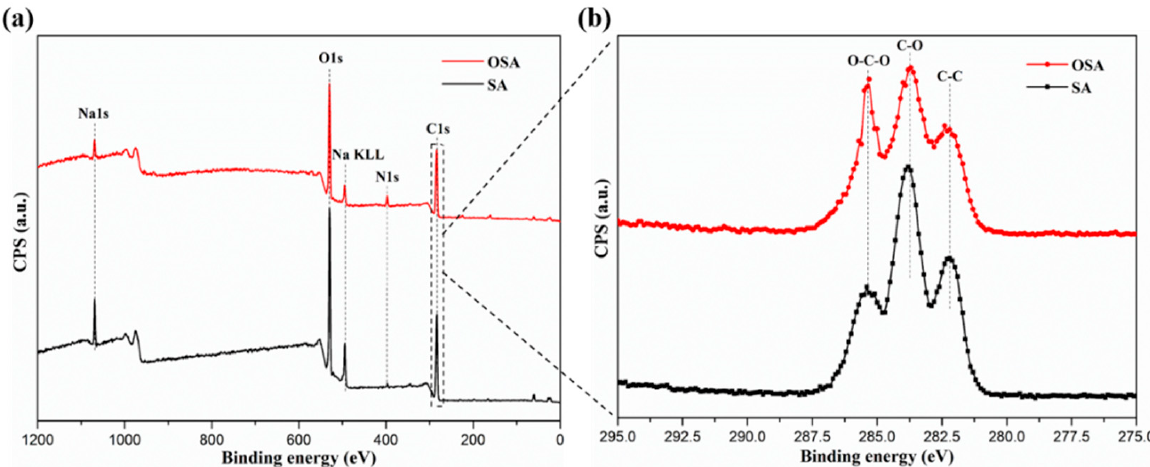
Figure 4. ( a ) FT-IR spectra and ( b ) 1 H NMR spectra of SA and OSA. As a complementary technique, XPS was performed to further verify the surface composition of resultant OSA. As shown in Figure 5a, XPS spectra of SA and OSA confirmed the presence of the anticipated peaks for Na (1069.02 eV), O (530.23 eV), N (397.54 eV), and C (284.68 eV), with an O/Na ratio close to the theoretical value of 6 [43], indicating that partial oxidation of alginate by NaIO 4 preserved the main structure and functional groups of alginate. In addition, the peak assignment of XPS C1s narrow scans of SA and OSA that could elucidate the bonding atmosphere has been marked in the spectra in Figure 5b according to the previous report [44]. It can be observed that the C1s narrow scan revealed three peaks at 285.46 eV (O–C–O), 283.87 eV (C–O), and 282.20 eV (C–C), respectively. It is found that the peak ratio of the O–C–O species to the C–O species in the C1s narrow scan of OSA was significantly higher than that of SA, due to the partial oxidation of alginate by NaIO4, which was consistent with previous results reported by Jejurikar et al. [24]. Thus, these results further verified the successful partial oxidation of alginate by NaIO 4 .